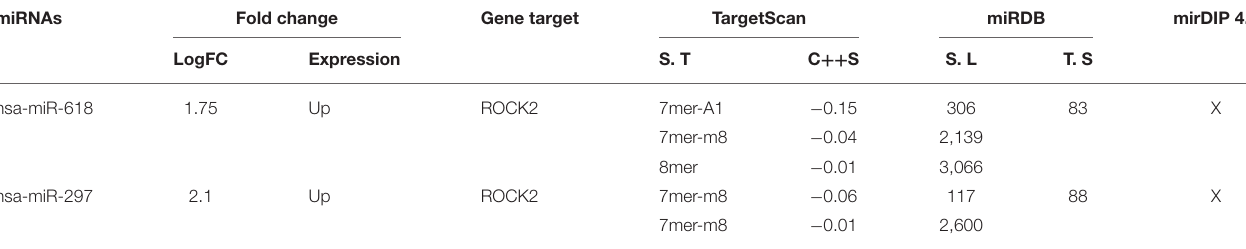
TABLE 4 | Software and metrics used to determine the binding of miRNAs with ROCK2. miRNAs Fold change